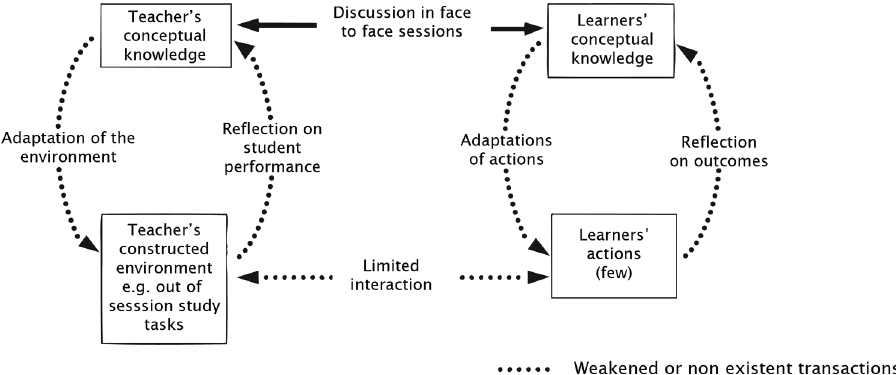
Figure 1. Student learning environment viewed in terms of weak or non-existent transactions within the conversational framework (Laurillard